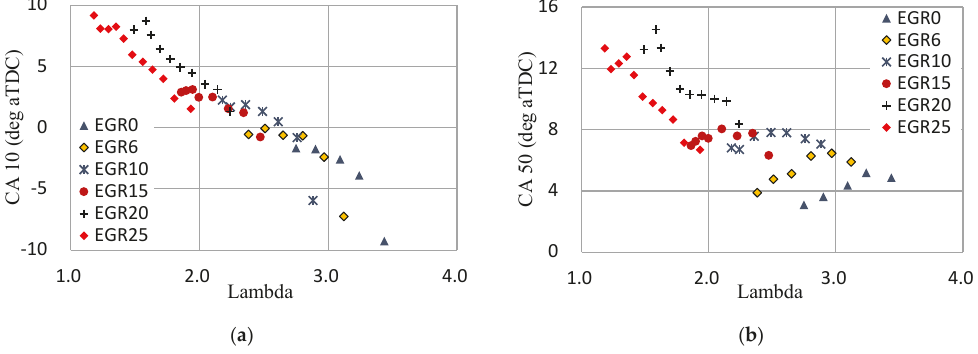
Figure 17. Effects of lambda on combustion phasing: ( a ) CA10; ( b ) CA50.